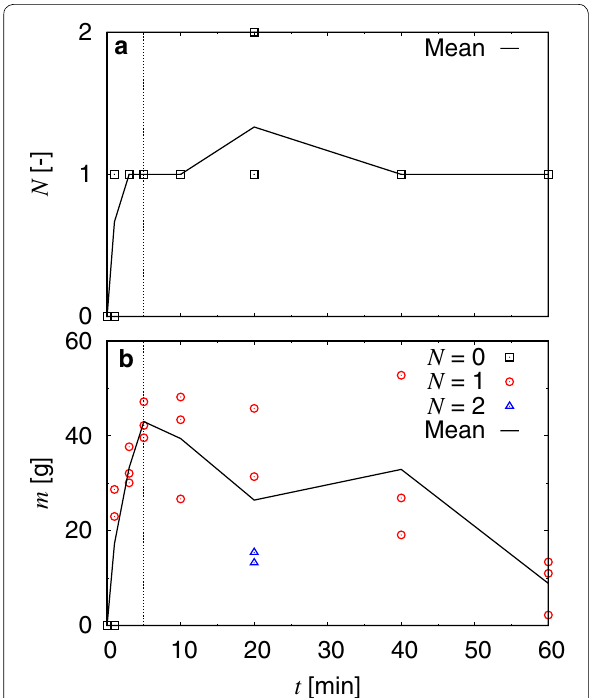
Fig. 5 Aggregate formation according to mixing time. Influence of rotation time, t , on aggregate formation in EXP1 ( d t = 32 – 63 µ m , C t = 33% , and C s = 9% ): a number of aggregates, N , and b mass of aggregate, m . The vertical dashed line indicates t = 5min , which is the boundary between the growth and decline stages of the